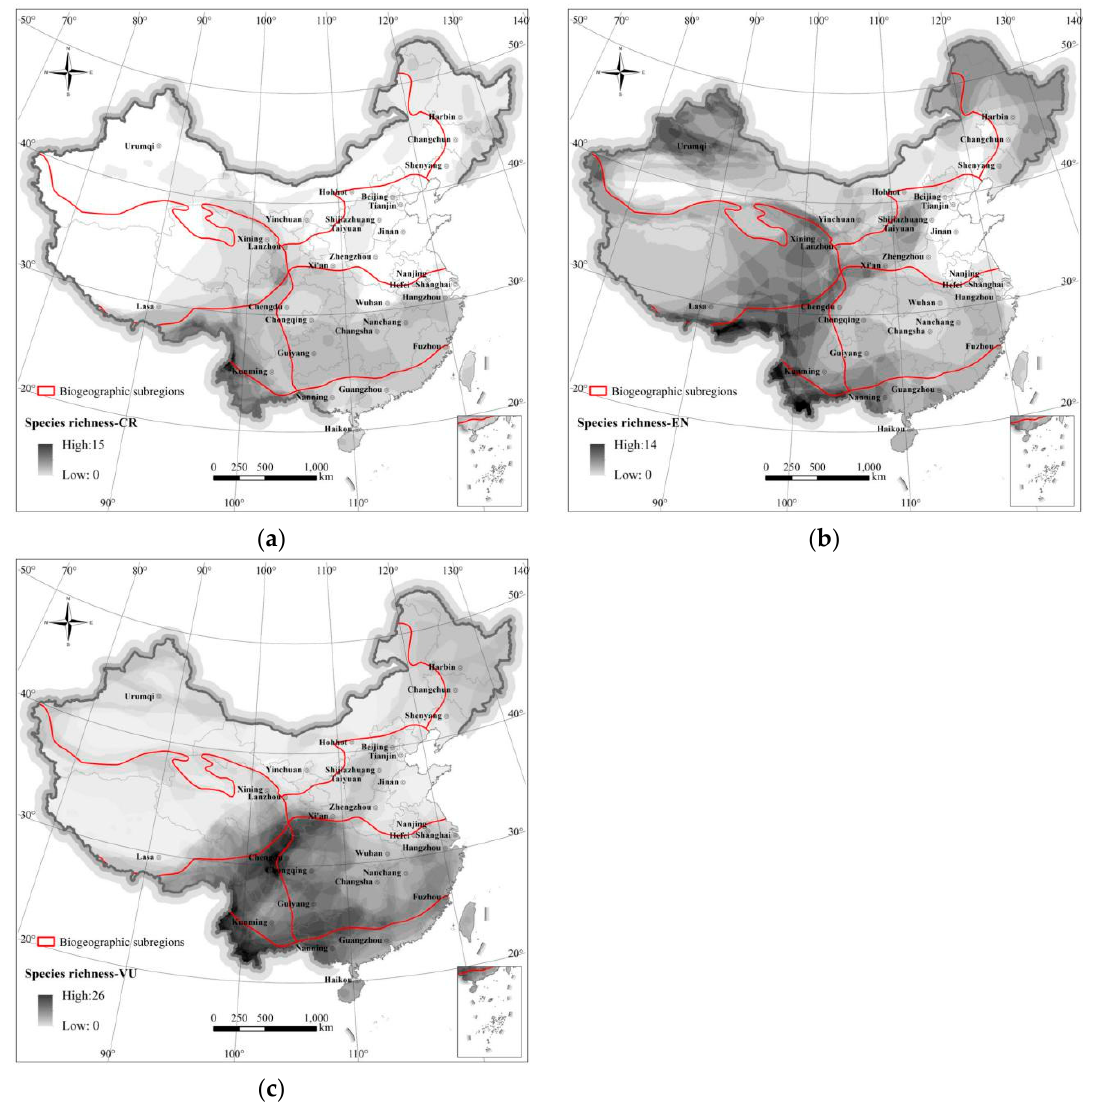
Figure 5. Spatial distribution of threatened species. ( a ) Critically Endangered species; ( b ) Endangered species; ( c ) Vulnerable species.